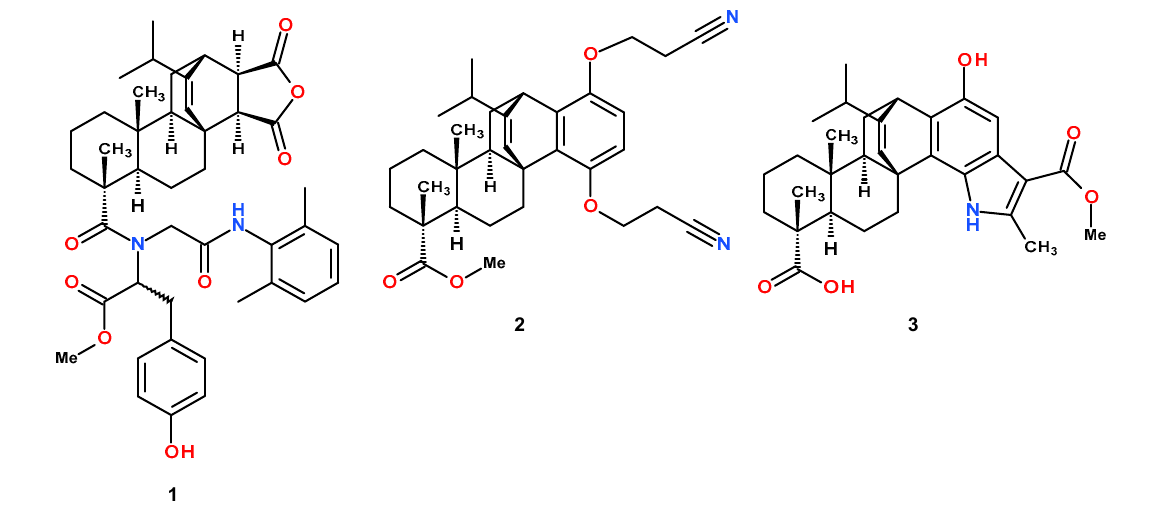
Figure 1. Structure of modified levopimaric acid diene adducts.